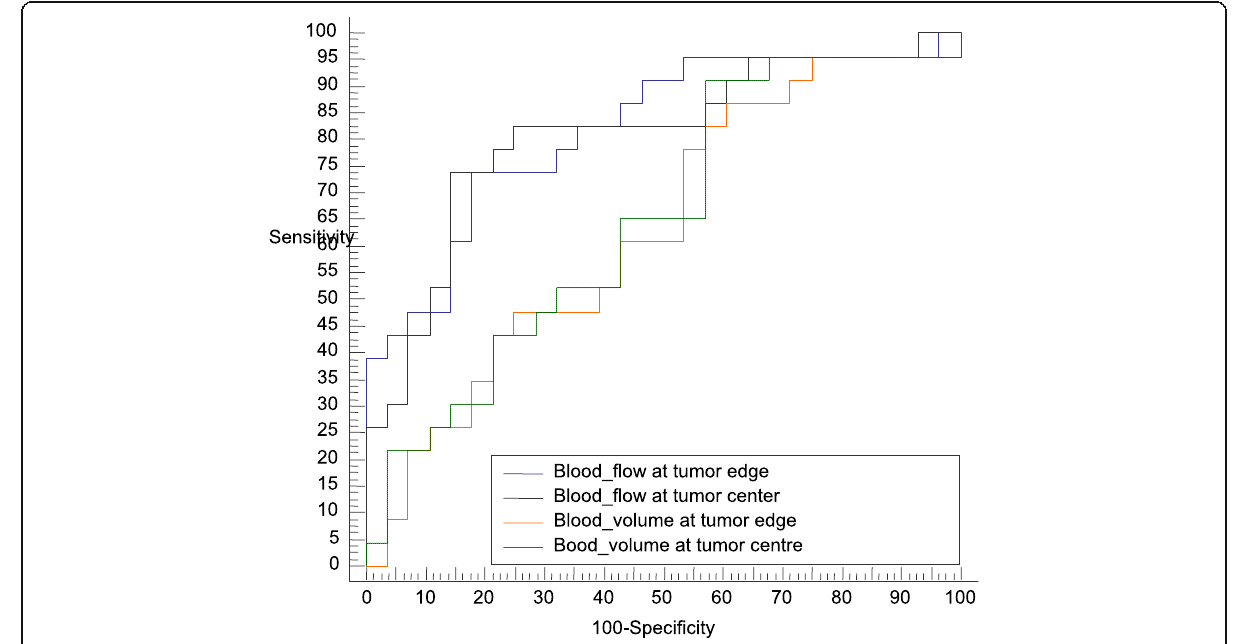
Fig. 3 Diagnostic performance of blood flow and volume in diagnosing moderately differentiated colorectal cancer